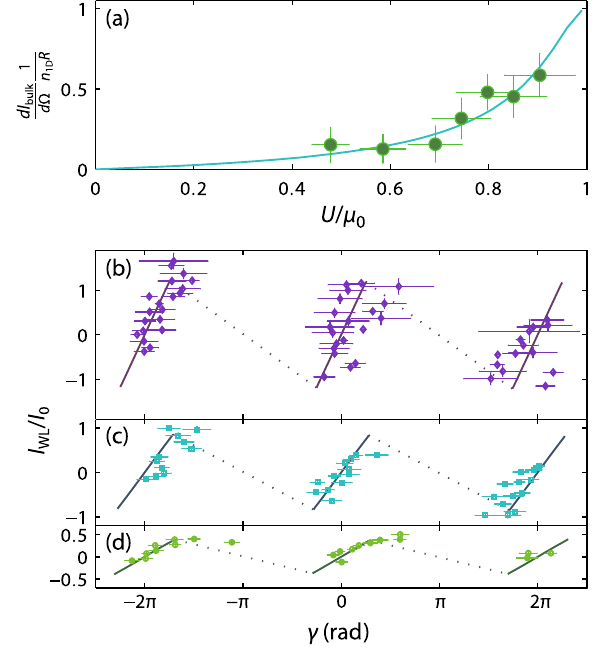
=d Ω FIG. 4. (a) Derivative of the initial bulk current dI bulk versus U , normalized to the expected value in the limit where U= μ ≥ 1 , n R . The solid line shows the prediction of the local- 0 1 D density approximation model. (b) – (d) Extracted current-phase relationships from the data in Fig. 3, for three different weak-link potential strengths U : (b) 0 . 45 μ 0 , (c) 0 . 6 μ 0 , (d) 0 . 7 μ 0 . γ is the phase across the weak link and I is the current through it, WL R Ω ≈ 5 × 10 5 atoms = s. The solid curves normalized to I 0 ¼ n 1 0 D represent the prediction of our theoretical model. The dashed lines merely guide the eye by connecting the multiple branches of the current-phase